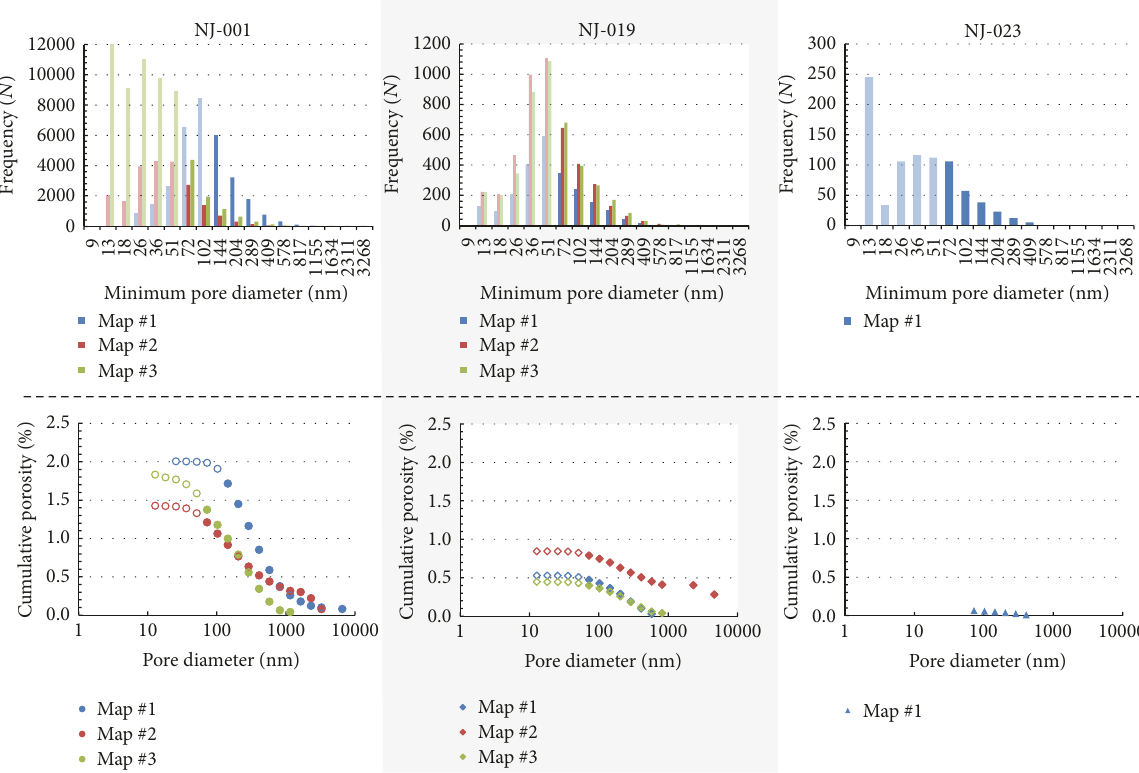
Figure 10: Pore size histograms and cumulative visible porosity for all